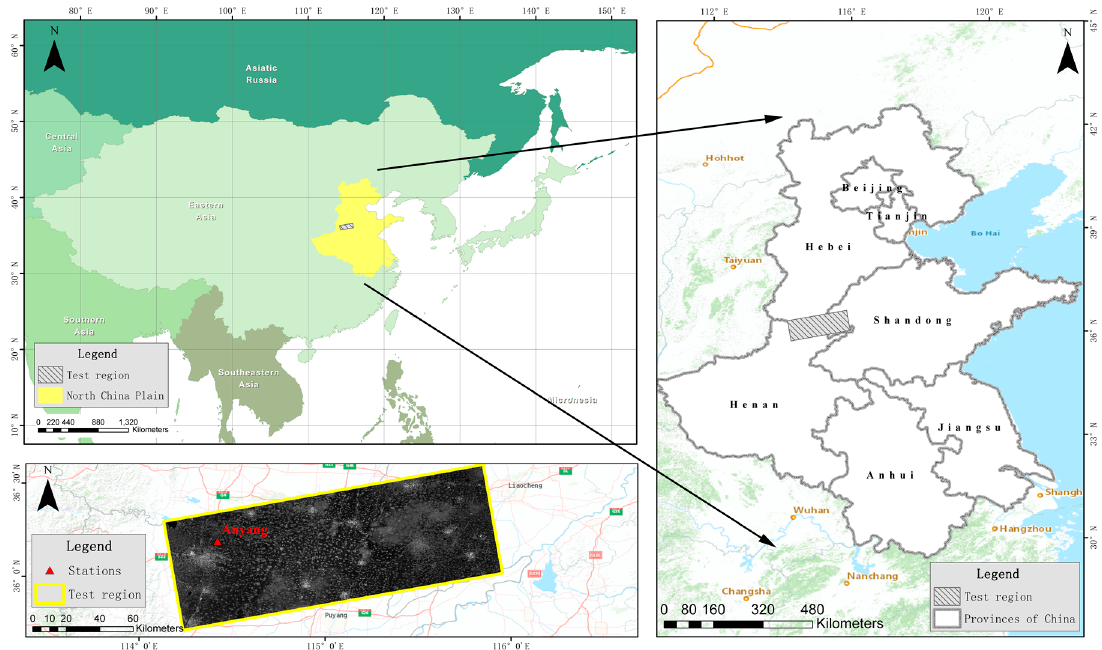
Figure 1. Location of the test region and an agro-meteorological station in the North China Plain, East Asia. Table 1. Phenological stages of winter wheat in the North China Plain.